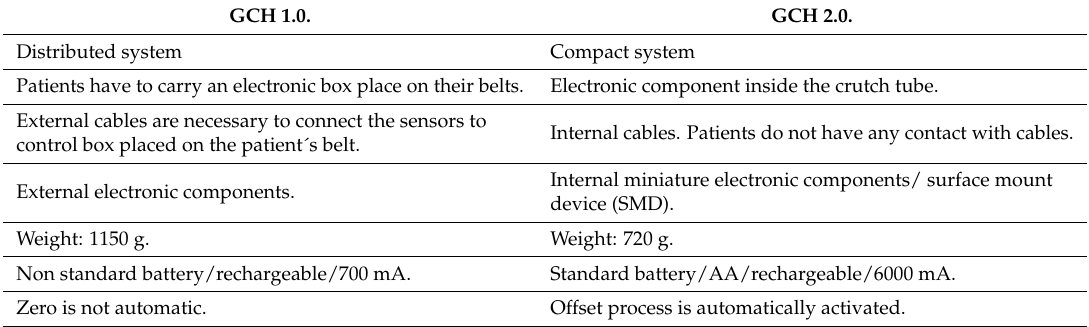
Table 1. The main differences between GCH 1.0 and GCH